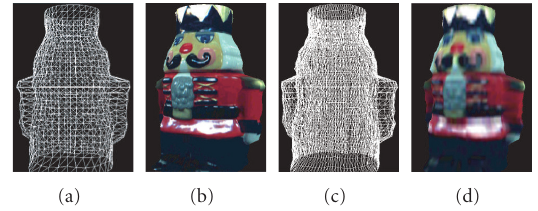
Figure 6: Two representations of the nutcracker texture + mesh models: left has lower quality mesh, requiring 125Kb total band- width, but higher perceptual quality; right has higher quality mesh, resulting in lower quality texture to keep total bandwidth at 134 Kb, but has lower perceptual quality.